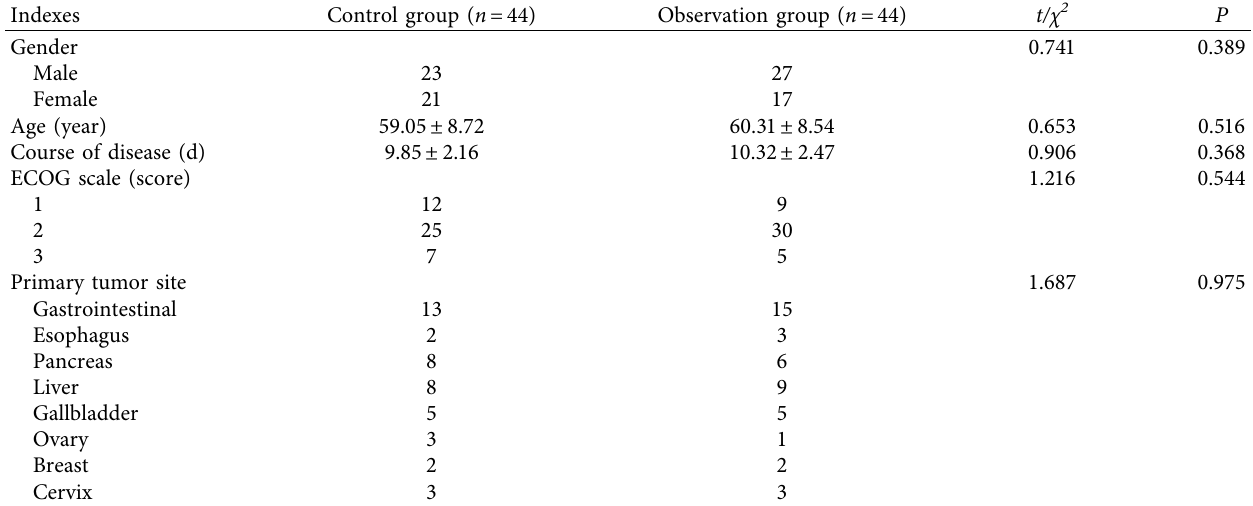
Table 1: Comparison of clinical data of the two groups of patients ( n , %).